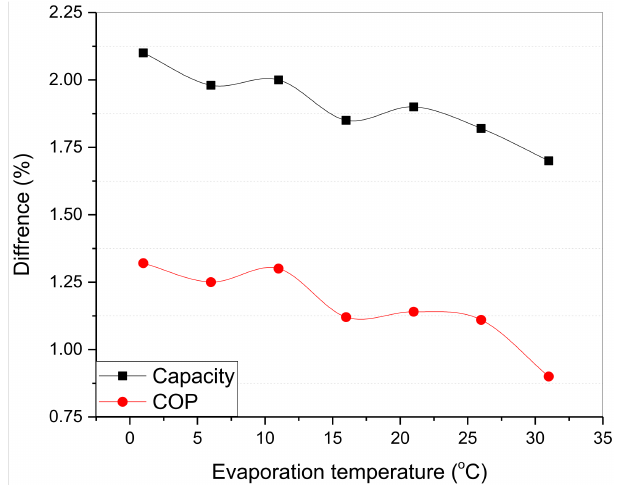
Figure 4. Variation of capacity and coefficient of performance ( COP ) between the developed model and the expected compressor’s